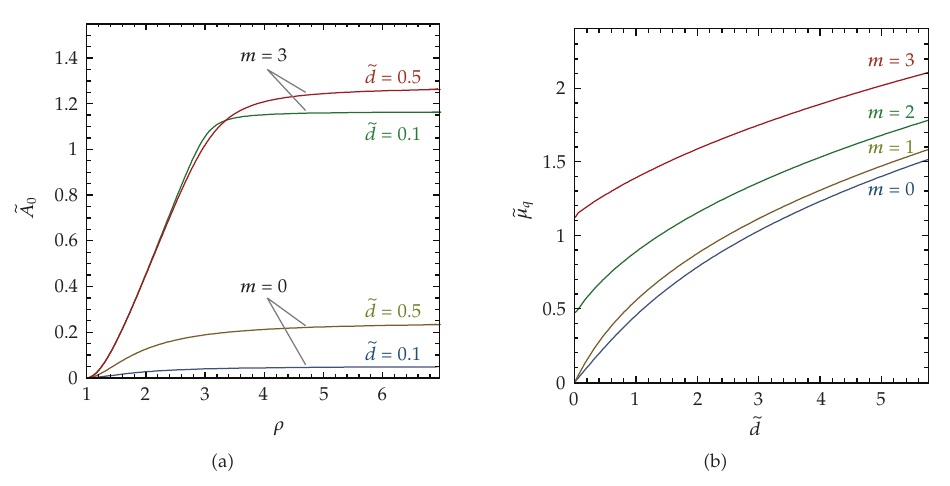
(cid:11) A 0 (cid:2) a (cid:3) and the resulting chemical (cid:11) d for